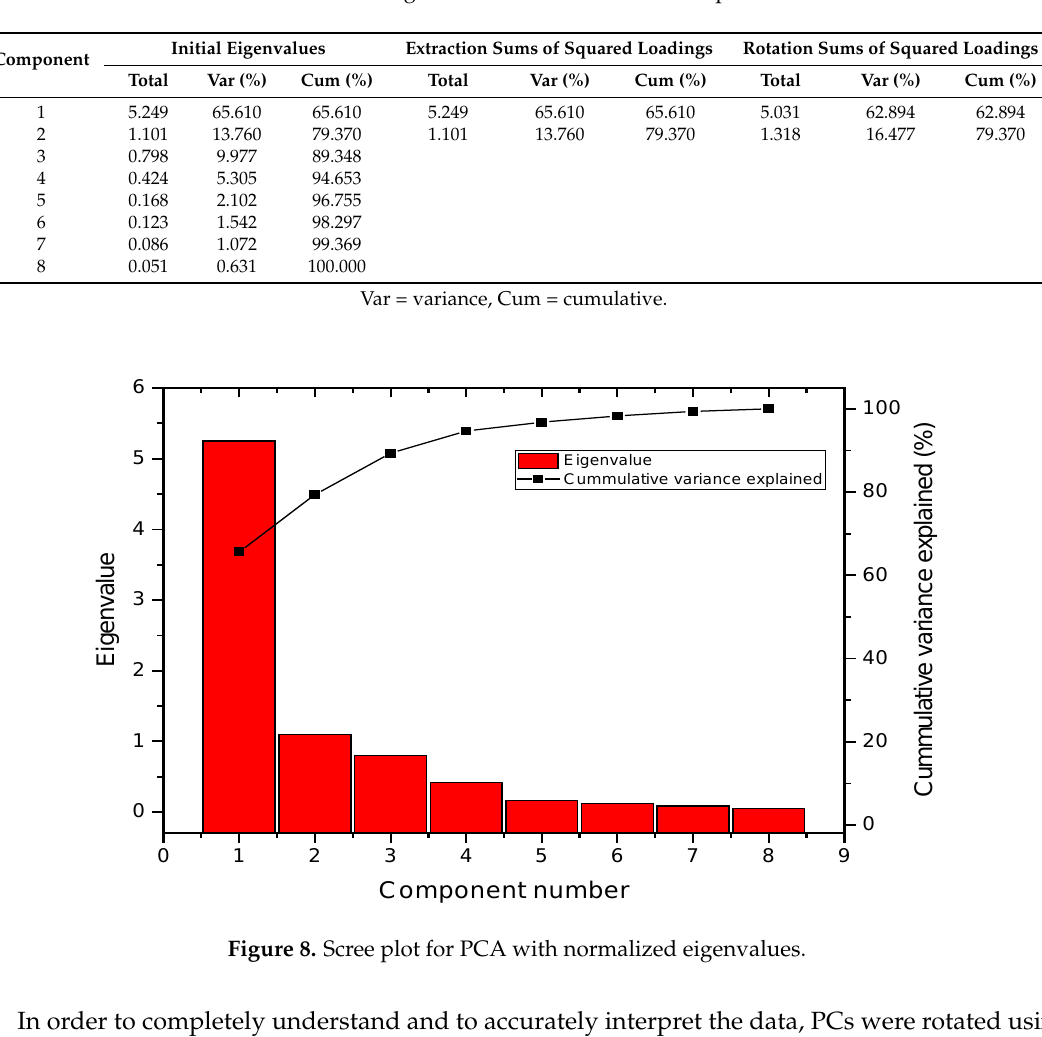
Table 6. Initial eigenvalues and total variance explained.